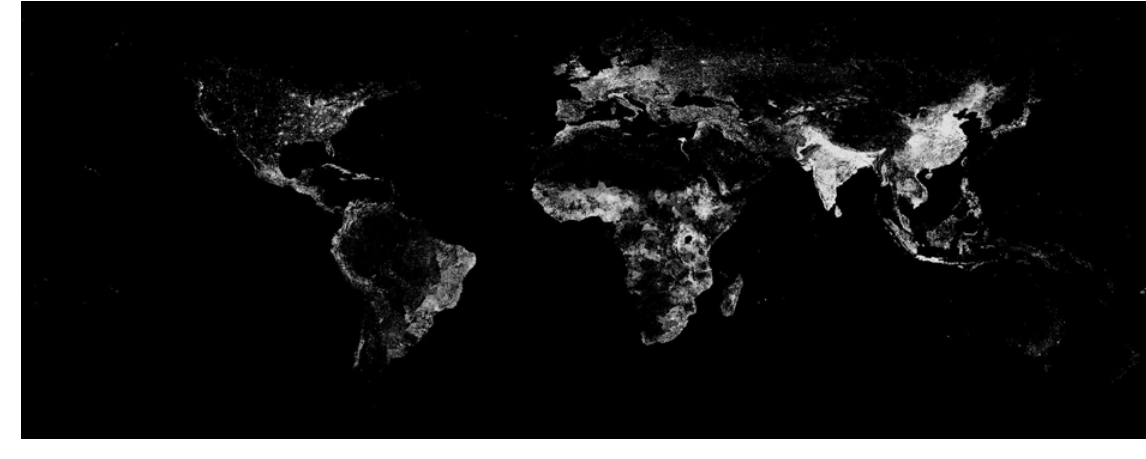
Figure 2. LandScan population grid of